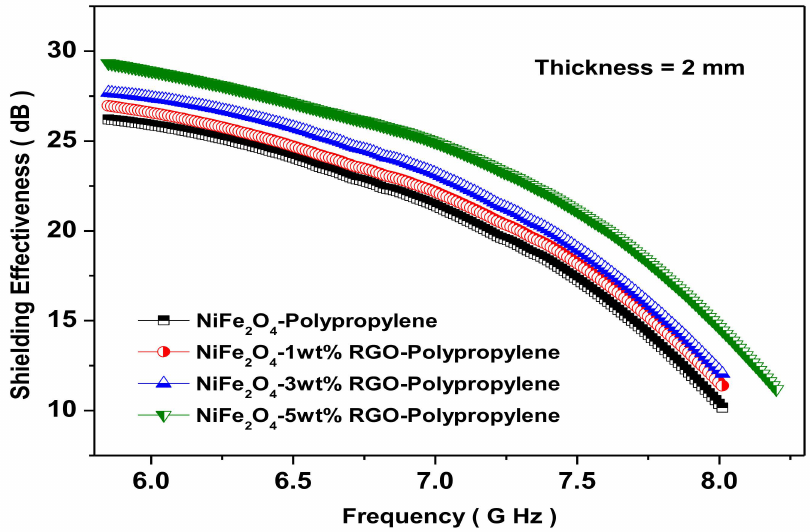
Figure 10. Electromagnetic interference shielding e ff ectiveness (dB) for NiFe 2 O 4 -Polypropylene, NiFe 2 O 4 -1wt% RGO-Polypropylene, NiFe 2 O 4 -3wt%RGO-Polypropylene, and NiFe 2 O 4 -5wt%RGO- Polypropylene elastomer nanocomposite samples at thickness 2